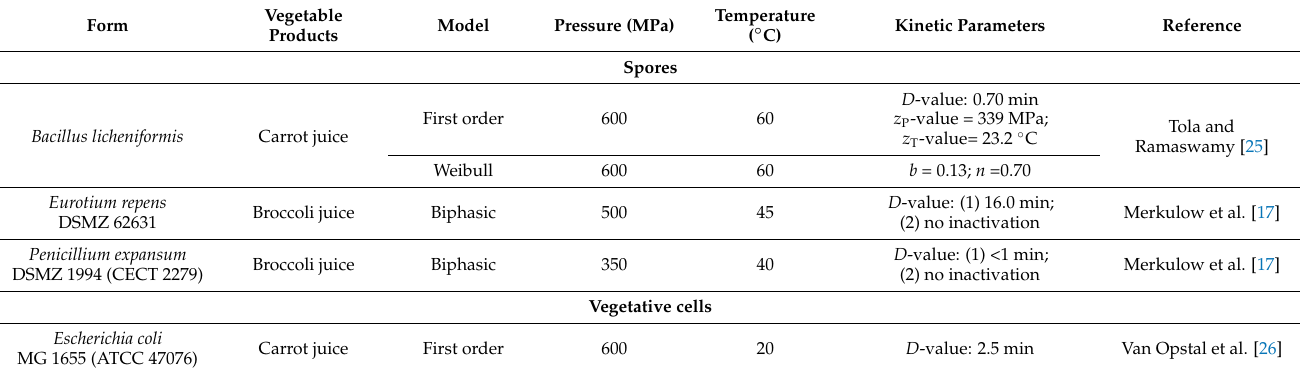
Table 2. Modeling the microbial inactivation in vegetable products after HPP and high pressure thermal processing (HPTP)